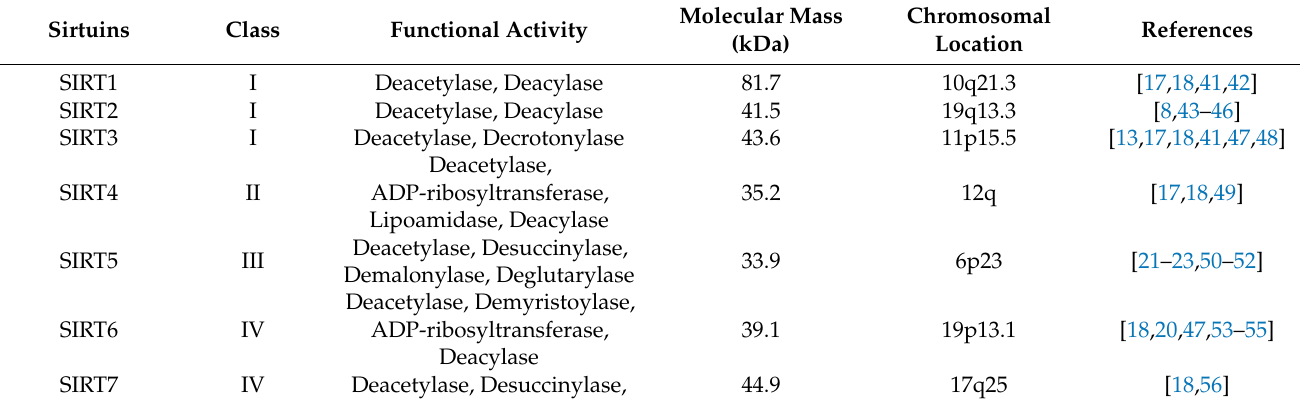
Table 1. The class, functional activity, molecular mass and chromosomal location of seven human SIRTs (SIRT1–7). Sirtuins Class Functional Activity